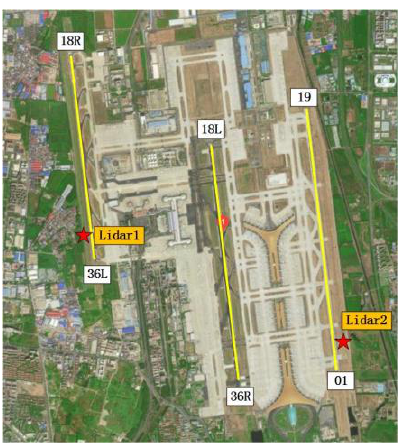
Fig.1. The geographical environment of BCIA.